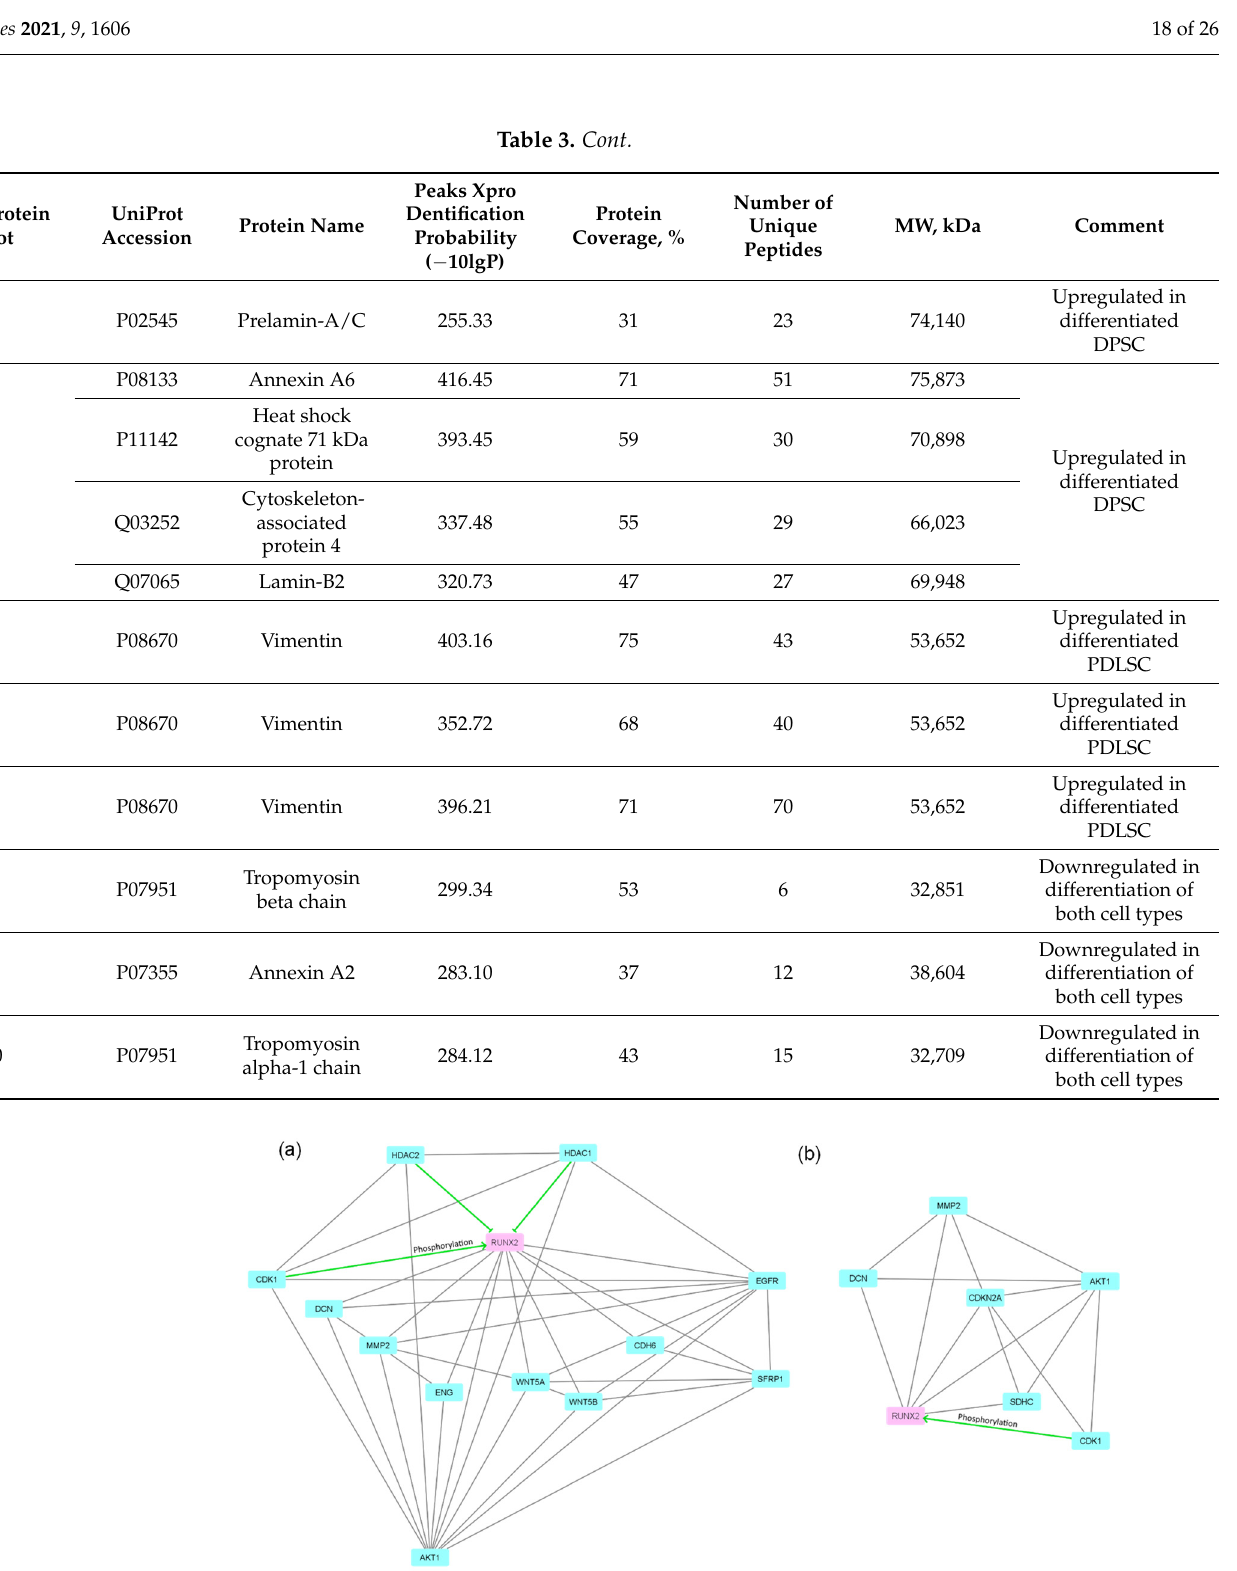
Figure 7. String interaction networks of proteins interacting with RUNX2 among PDLSCs-specific proteins founded in control cells ( a ) and cells after induction of osteogenic differentiation ( b ). Green—protein-protein interactions with experimental evidence. The image was obtained in the Cytoscape software v. 3.8.1 (Cytoscape Consortium; https://cytoscape.org/; accessed on 21 July 2021). According to mass-spectrometry data, the proteomes of DPSC and PDLSC are dif- ferent. PDLSC proteomes are enriched for proteins, responsible for cell cycle control, proliferation,